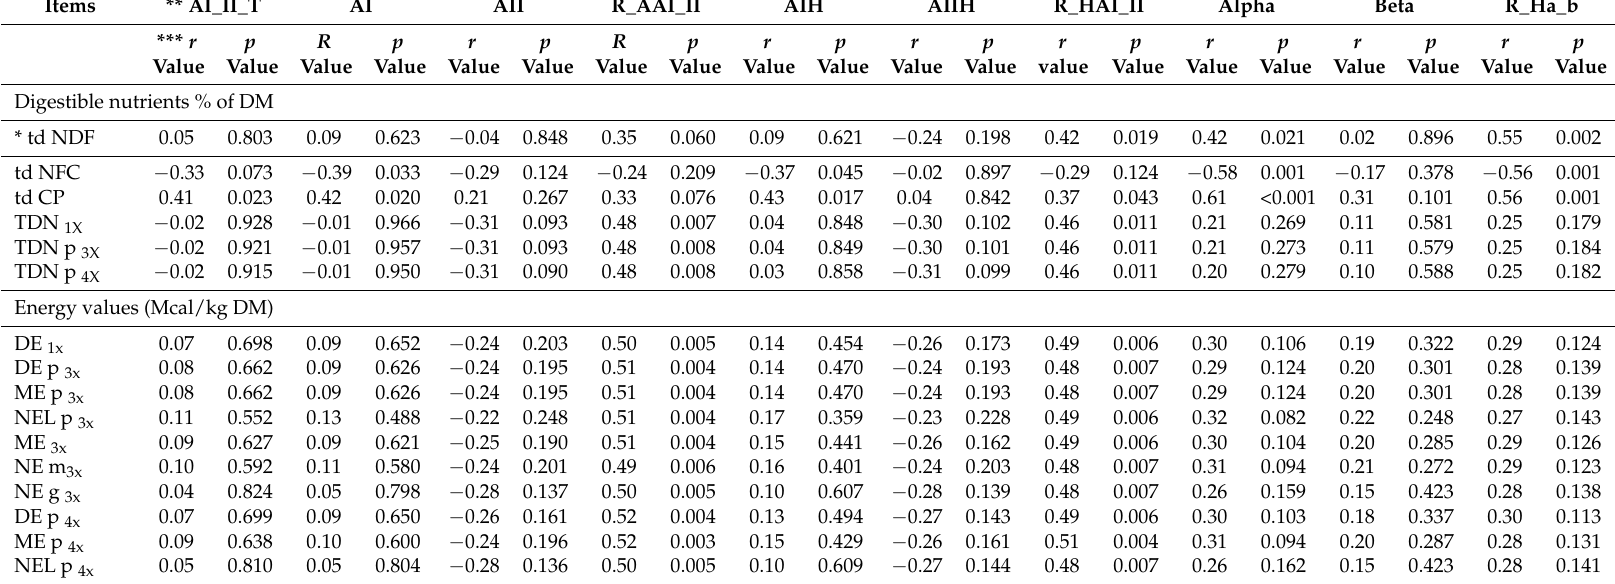
Table 10. Correlation analyses between protein structure spectral characteristics and estimated energy values of canola